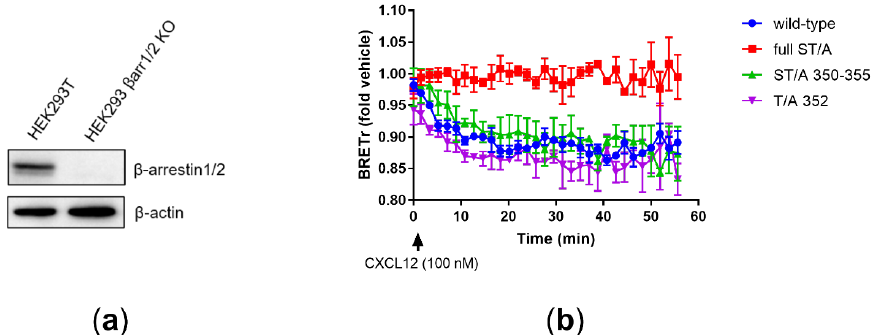
Figure 6. Internalization of ACKR3 wild-type and mutant receptors in a β -arrestin1/ β -arrestin2 KO cell line upon CXCL12 stimulation. ( a ) Western Blot detection of β -arrestin1/ β -arrestin2 expression in HEK293T cells and CRISPR HEK293 β -arrestin1/ β -arrestin2 KO cells; ( b ) CXCL12-induced K-Ras co-localization with ACKR3 wild-type and mutant receptors over time as measured by BRET in CRISPR HEK293 β-arrestin1/β-arrestin2 KO cells. Representative curves of three independent experiments with triplicates shown as mean ± SD.